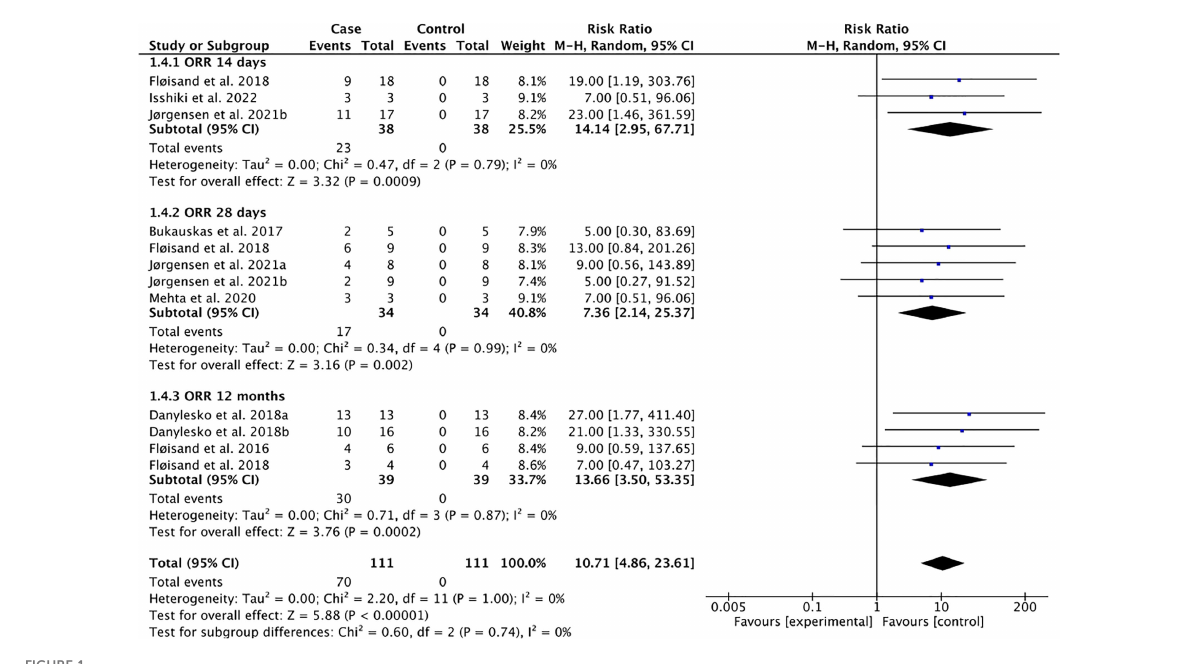
FIGURE 1 Overall response rate (ORR) following the use of vedolizumab for